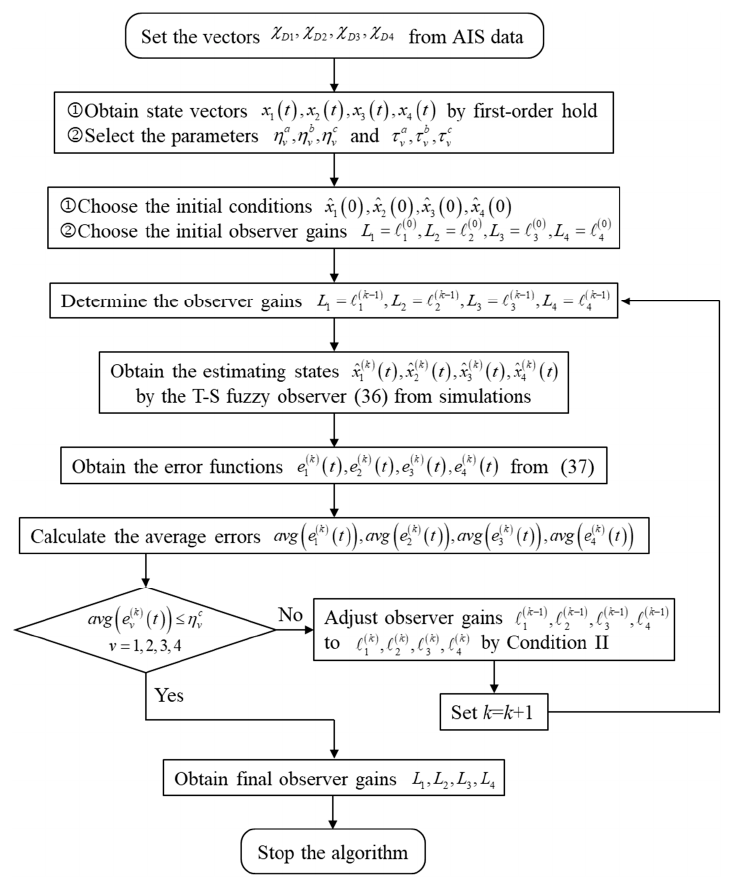
Figure 2. Flow chart of T-S fuzzy observer gain design algorithm.